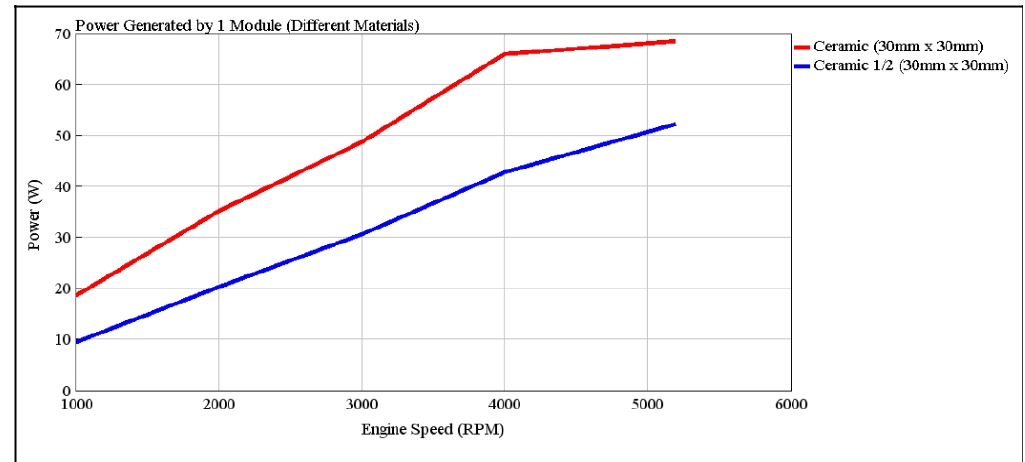
Figure 19. Power generated by different materials (1 module).